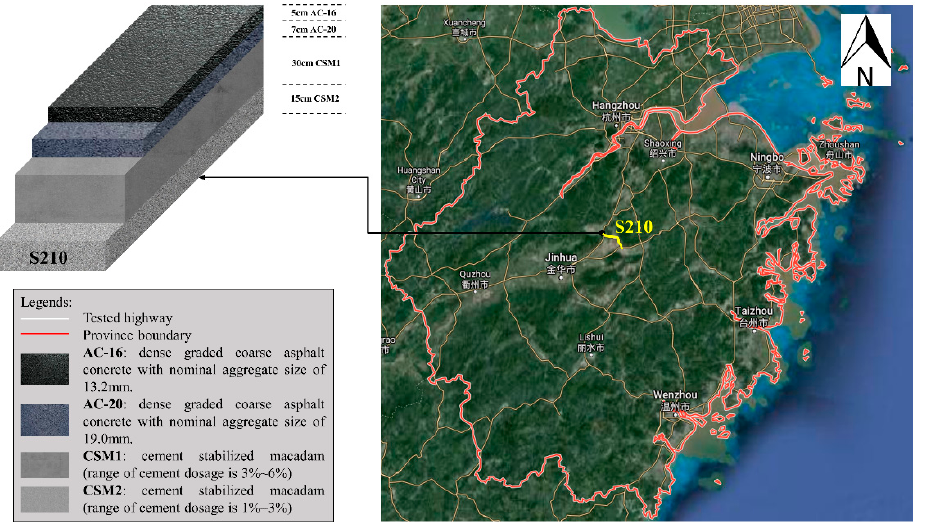
Figure 2. View of the tested road network, construction scheme and materials. The map used is the free version of Google Earth 2020.